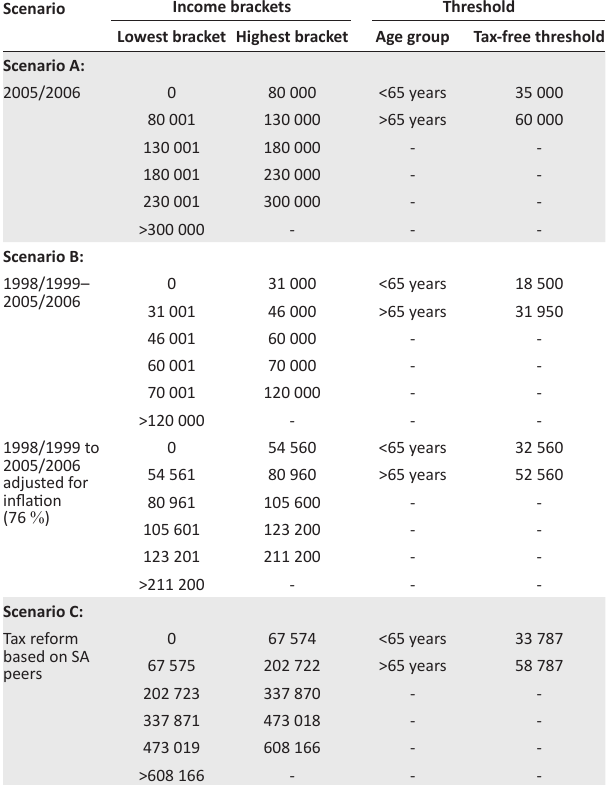
TABLE 4: Comparison of micro-simulation model and South African Revenue Service data by taxable income group.